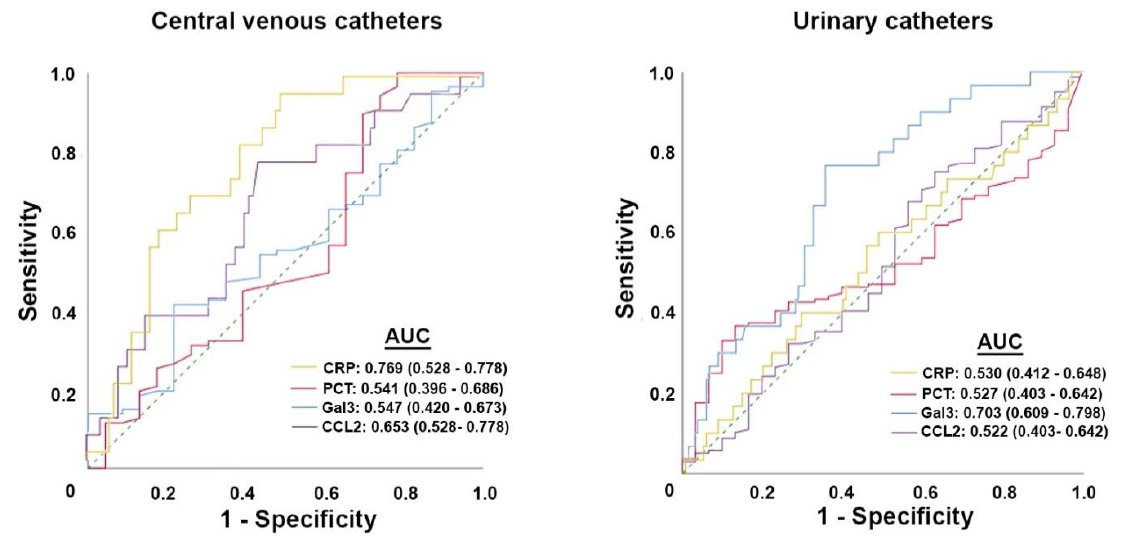
Figure 4. Receiver operating characteristics (ROC) plot of selected biochemical variables in the catheter-bearing patients with respect to the presentation of catheter-related infections. AUC: area under the curve; CRP: C-reactive protein; Gal3: galectin-3; PCT: procalcitonin.